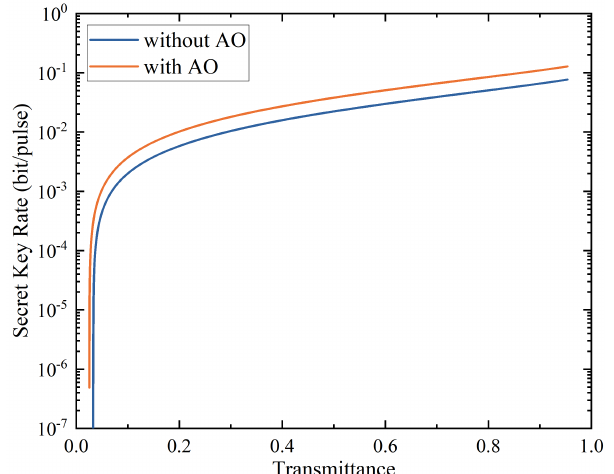
Figure 5. The performance of the AO-enabled DM CVQKD system for the four-state